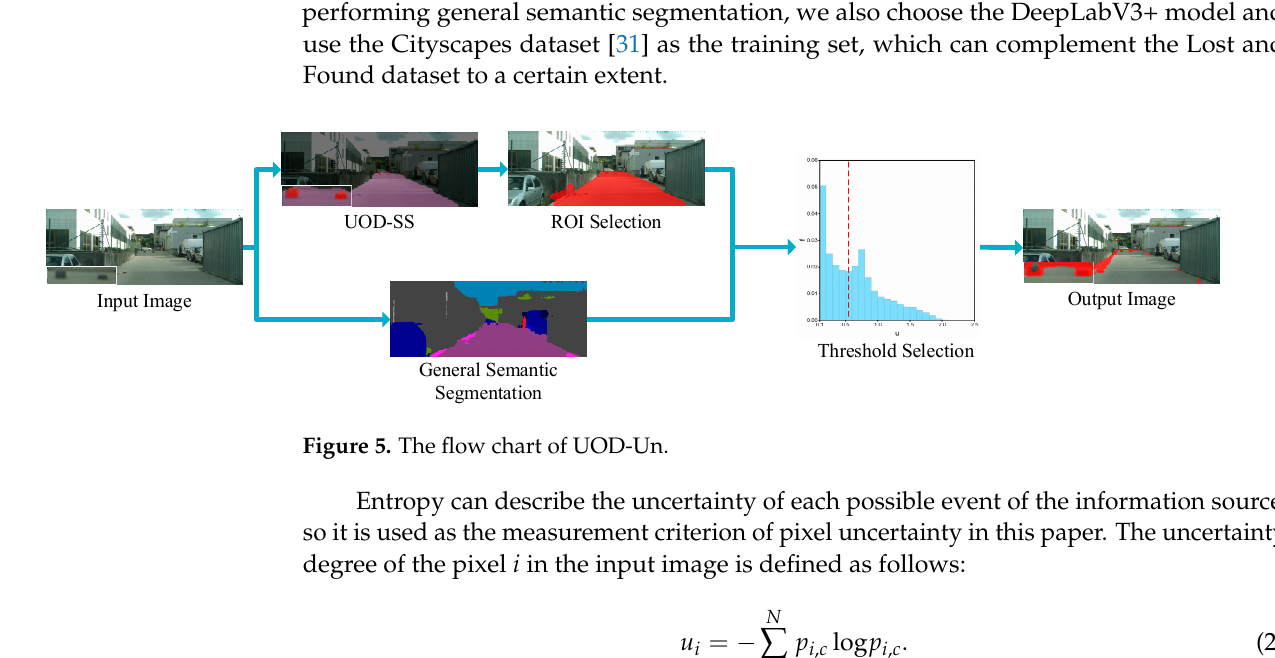
Figure 4. Uncertainty degree distribution of general semantic segmentation: ( a ) general semantic segmentation; ( b ) uncertainty degree distribution.